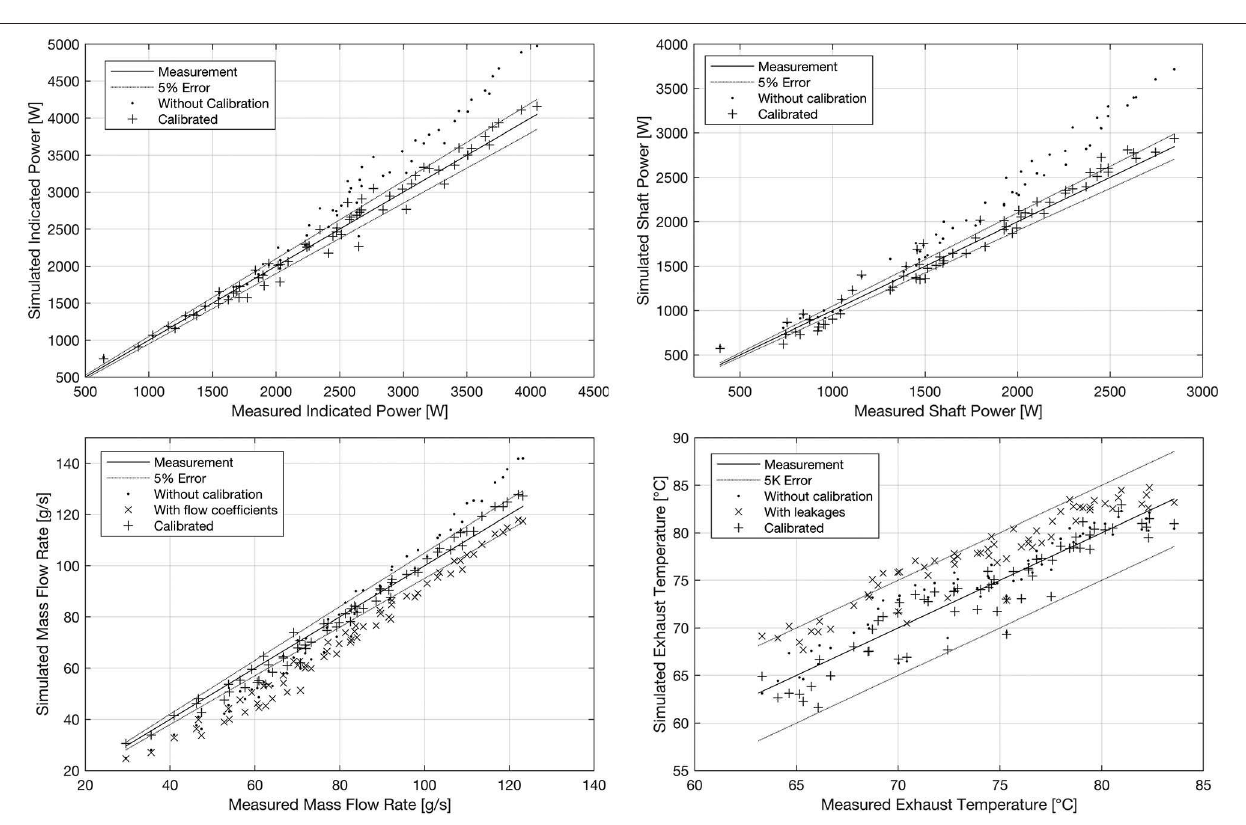
flow coefficients is the only way to modify pressure drops and therefore calibrate the simulated indicator diagram. Figures 9 , 10 (top left) show differences between some measured and simulated indicator diagrams and indicated powers, respectively. Without calibration, indicator diagrams show that the model underestimates the pressure drops and